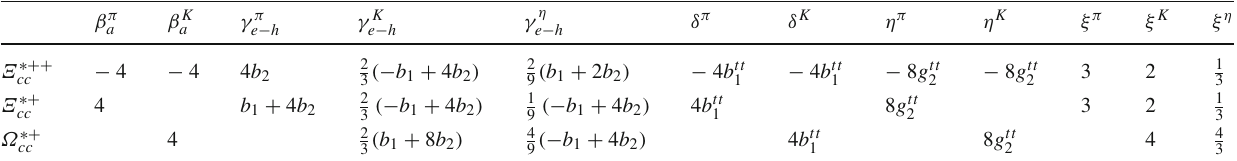
doubly charmed baryon magnetic moments from Fig. 2. For diagrams (e)–(h), the 2 , b bb , b bt and b bt in 1 , 2 1 , 2 1 , 2 1 , 2